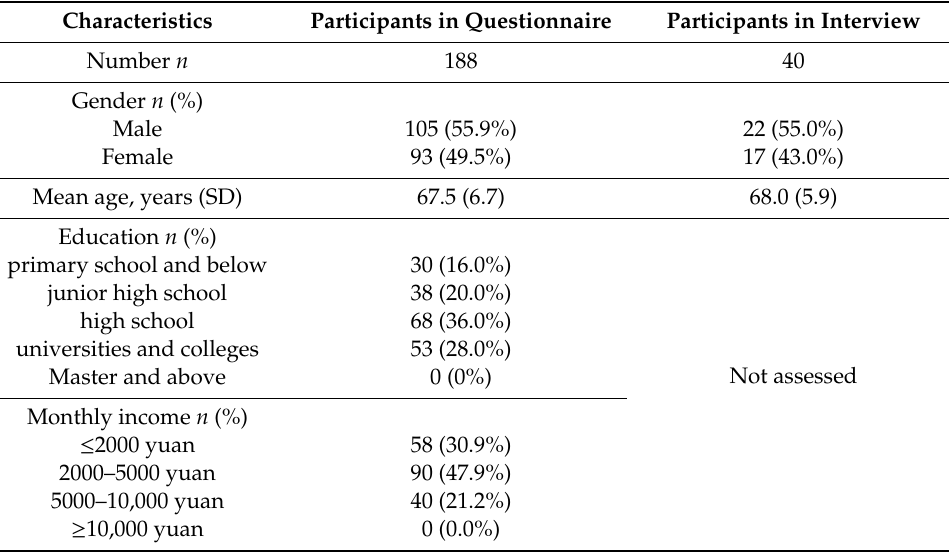
Table 1. Participant characteristics in formal questionnaire and interview